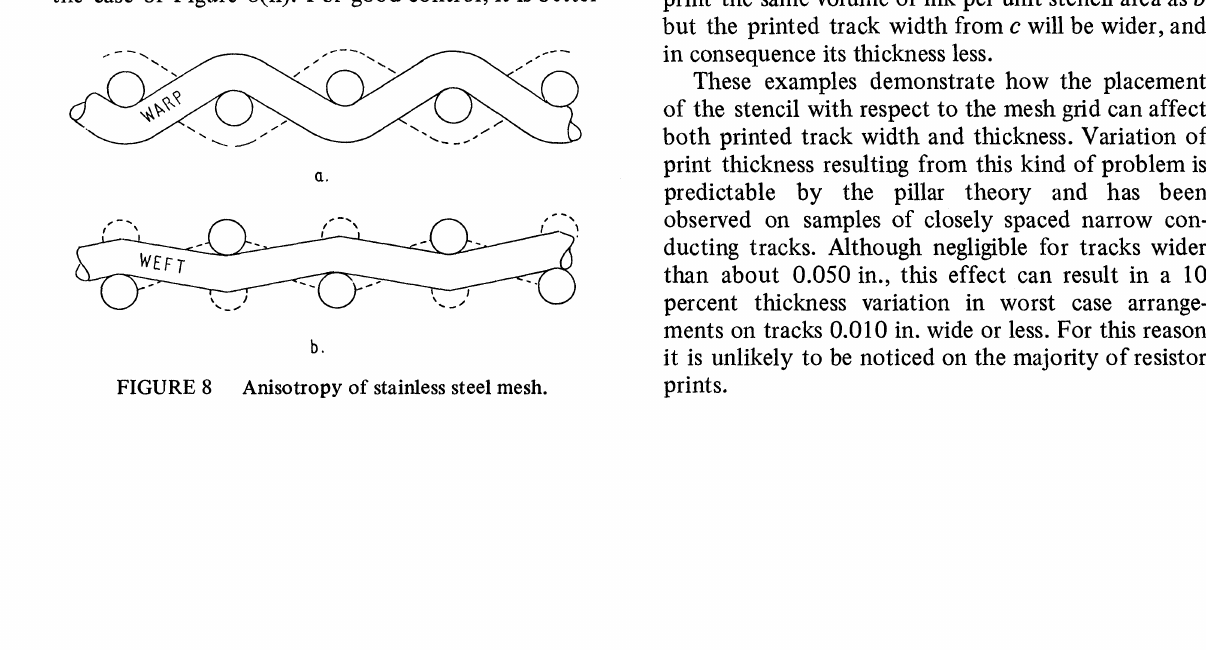
FIGURE 9 Positional effect of the stencil. A third stencil track c of equal width to b